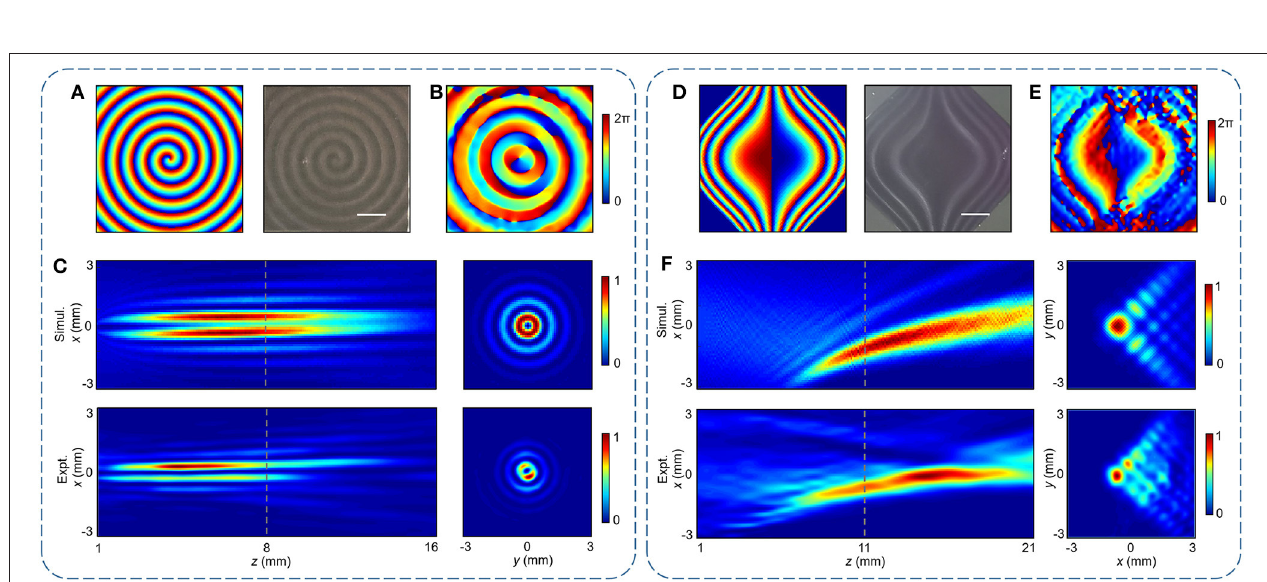
FIGURE 4 | Spiral axicon and polarization Airy mask. (A) Phase diagram and photograph of a Bessel vortex generator. (B) Far-field phase diagram of the generated Bessel vortex beam. (C) Simulated and measured intensity distributions of the generated Bessel vortex beam in the xz - and xy -planes. (D) Phase diagram and photograph of a polarization Airy mask. (E) Far-field phase diagram of the generated Airy beam. (F) Simulated and measured intensity distributions of the generated Airy beam in the xz - and xy -planes. All scale bars indicate 2mm.